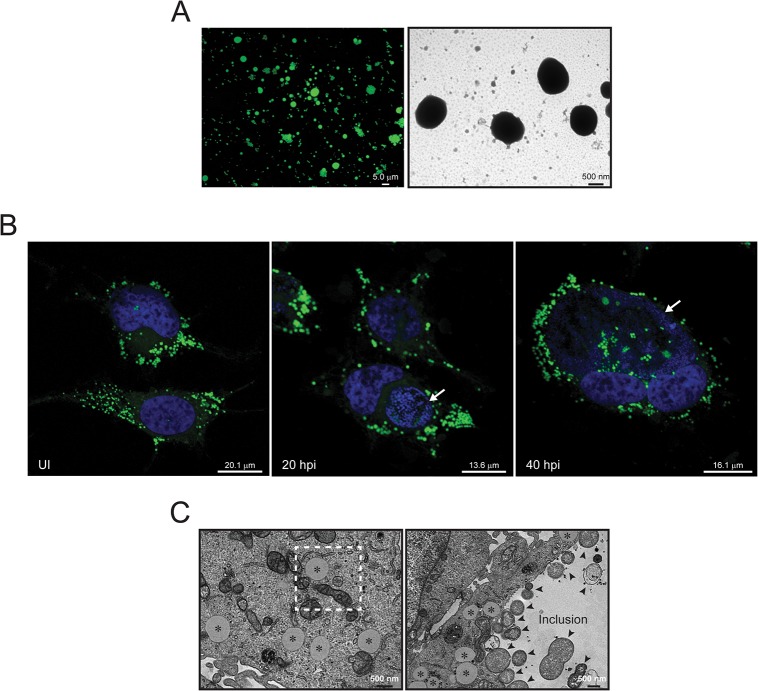
Morphology of LDs in uninfected and C. trachomatis-infected HeLa cells.(A) A fresh suspension of LDs isolated from HeLa cells was stained with BODIPY 493/503 for 15 min and imaged by fluorescence microscopy (left panel) or processed for TEM (right panel). LDs appear as intact spherical structures. Since no morphological differences between LDs from uninfected and infected cells were observed, a representative image of LDs isolated from uninfected cells is shown (B) Representative confocal images of HeLa cells, uninfected (UI) or infected with C. trachomatis LGV-L2 for 20 h (20 hpi) or 40 h (40 hpi). Cells were stained with BODIPY 493/503 to visualize LDs (green) and Hoechst was utilized to visualize host and bacterial DNA (blue). Bacterial replicative vacuoles (inclusions) are indicated with white arrows. (C) TEM images of uninfected (left panel) and C. trachomatis infected (20 hpi, right panel) HeLa cells. LDs (asterisk) and C. trachomatis (black arrows) are indicated. Note the close apposition of LDs with mitochondria and ER-like membranes (dashed square, left panel) and with the inclusion (right panel). In all cases (A-C) HeLa cells were stimulated with oleic acid 100 μM for 14 h prior to fixation and/or staining to enhance LD production.